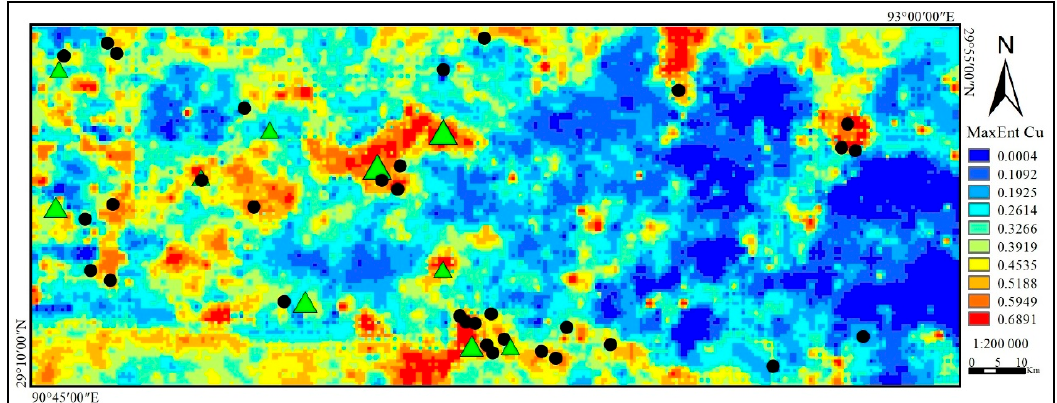
Figure 11. Continuous-scale copper perspective map of the Mila Mountain generated from the MaxEnt model.